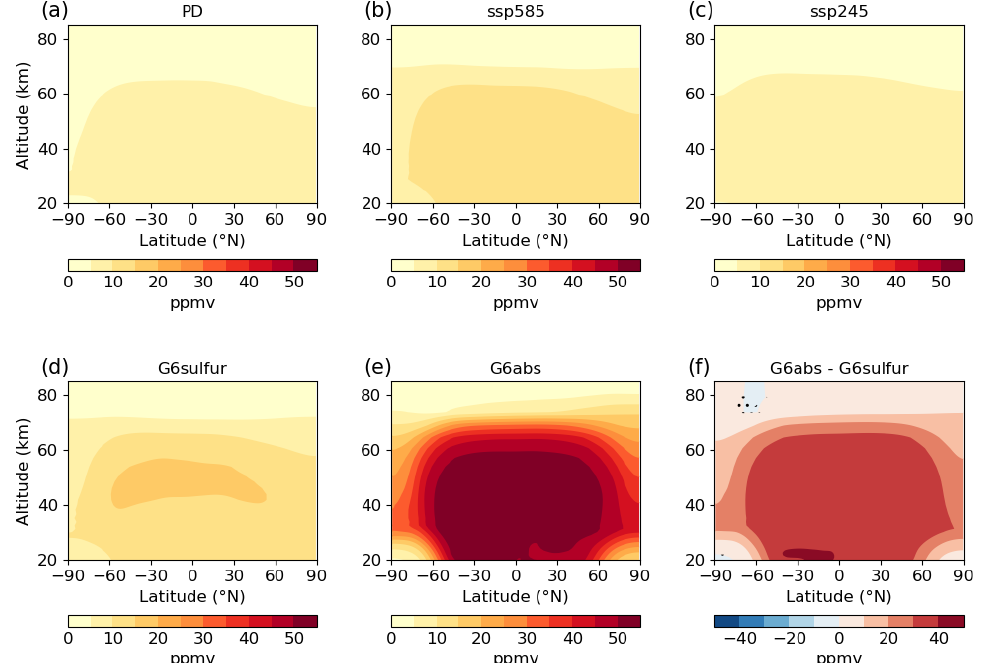
Figure 7. Stratospheric water vapour concentrations for (a) PD, (b) SSP5–8.5 (2081–2100), (c) SSP2–4.5 (2081–2100), (d) G6sulfur (2081– 2100) and (e) G6abs (2081–2100). (f) Changes in water vapour concentrations for G6abs–G6sulfur (2081–2100), where stippling represents areas that are not significant at the 5% level using a two-tailed t